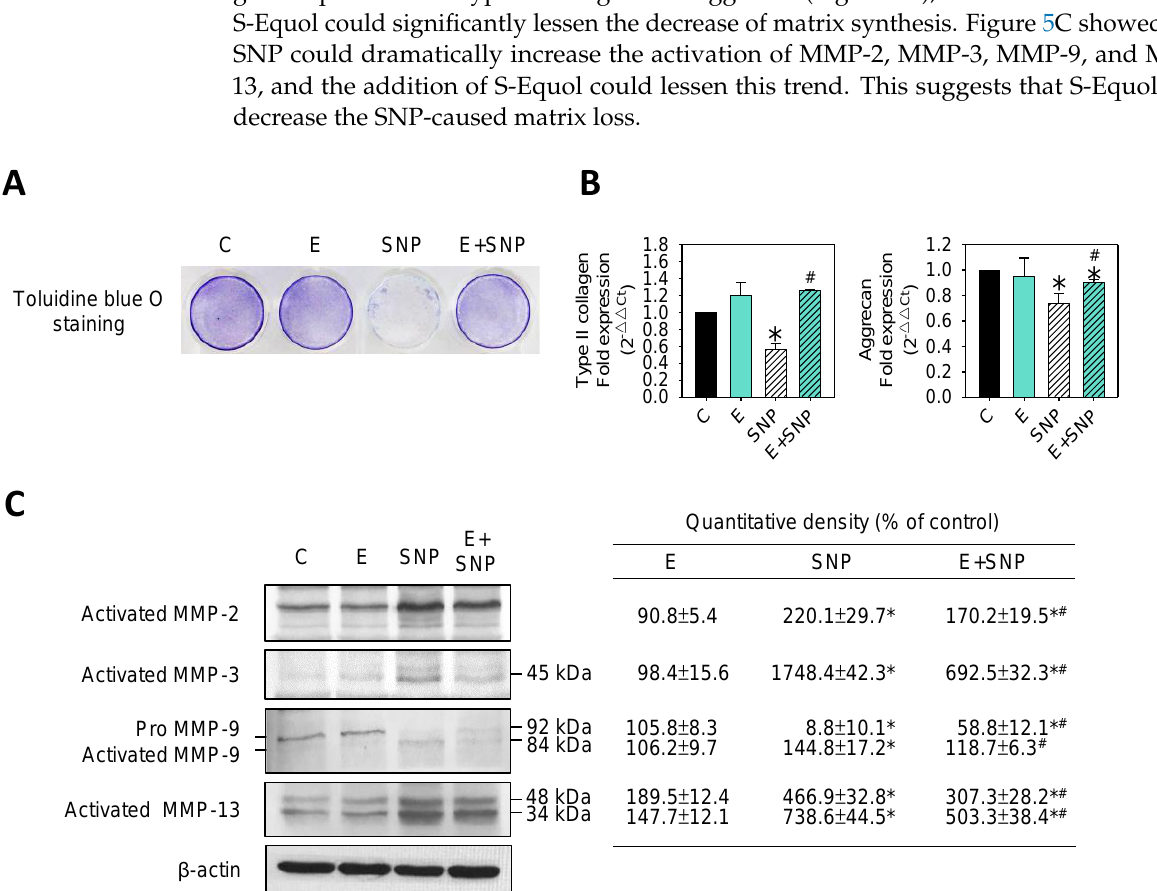
Figure 5. The effect of SNP and/or S-Equol on extracellular matrix and MMPs expression of primary chondrocytes. After cells were treated with S-Equol for 24 h in the presence or absence of SNP for another 24 h, ( A ) glycosaminoglycan (GAG) contents were determined by toluidine blue O staining followed by colorimetric assay; ( B ) mRNA levels of type II collagen and aggrecan were measured by real-time PCR and β-actin was used as the internal control. The data are expressed as fold changes compared to those in untreated control; ( C ) MMP-2, MMP-3, MMP-9, and MMP-13 protein levels were measured by Western blotting and β-actin was used as the internal control. The data of the right panel are expressed as the relative density compared to that in untreated cells (control), which was 100%. The results are the mean ± S.D. for three separate experiments. * p < 0.05 compared to the corresponding untreated control. # p < 0.05 compared to the corresponding SNP treated group.